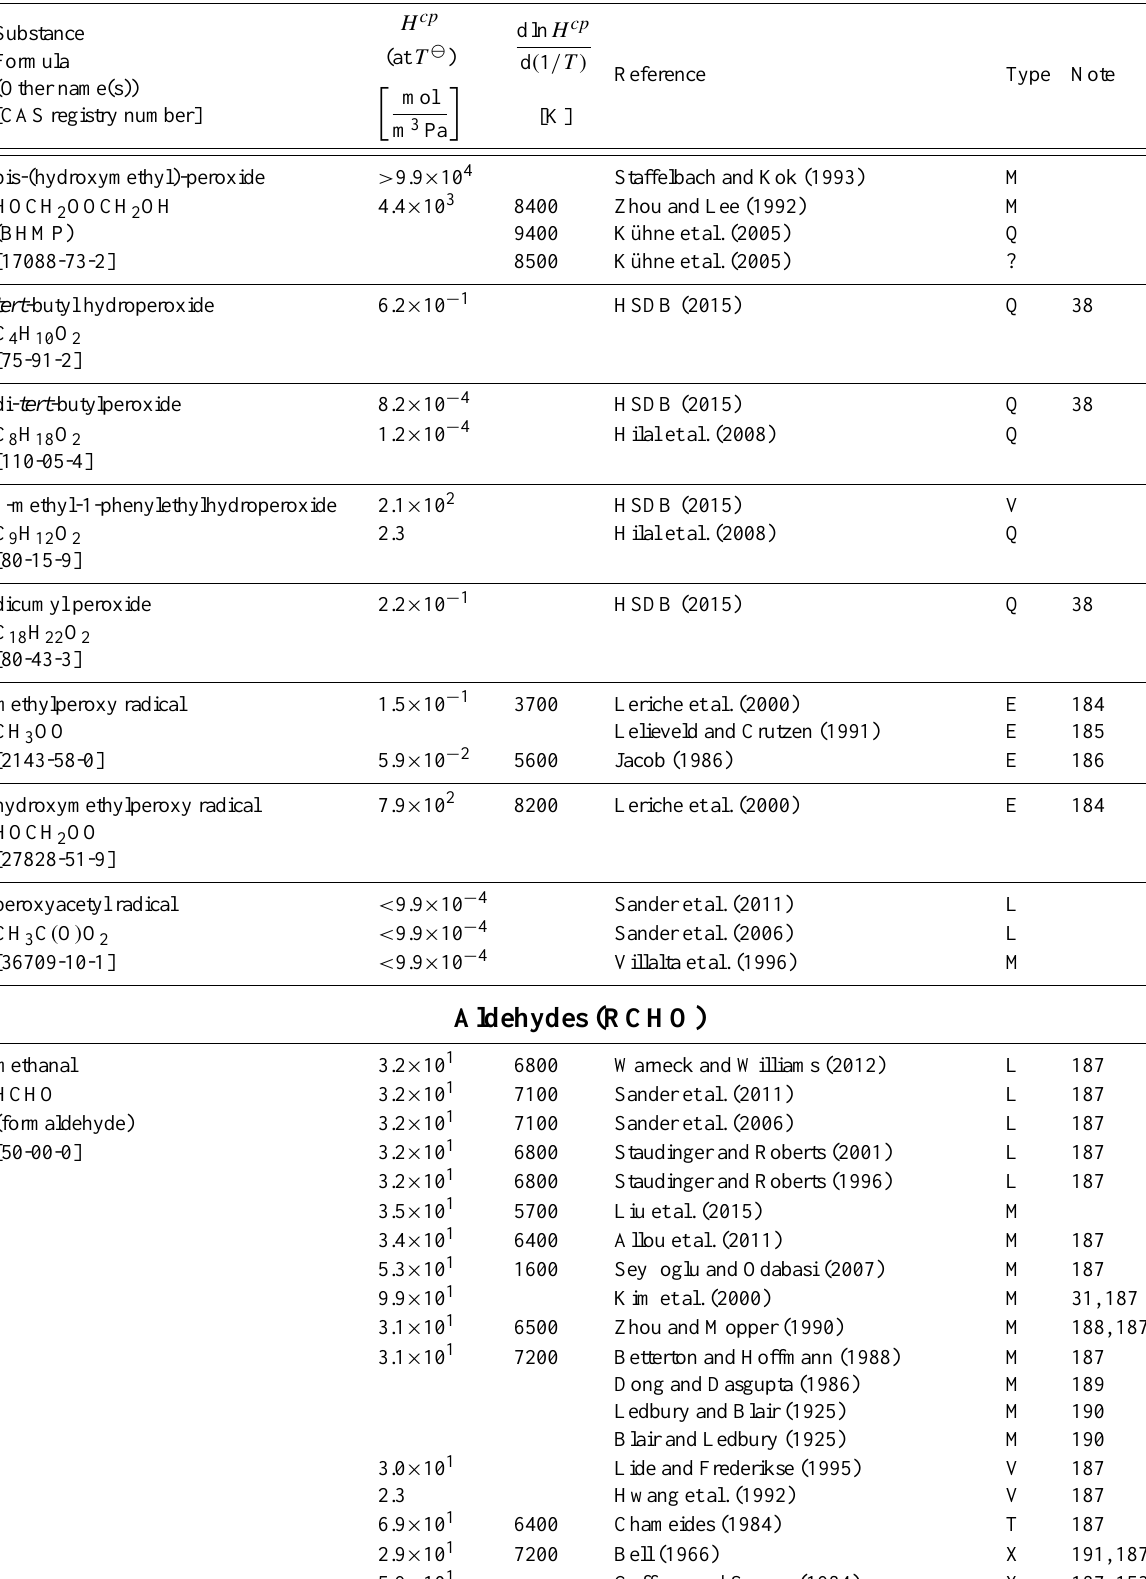
Table 6: Henry’s law constants for water as solvent